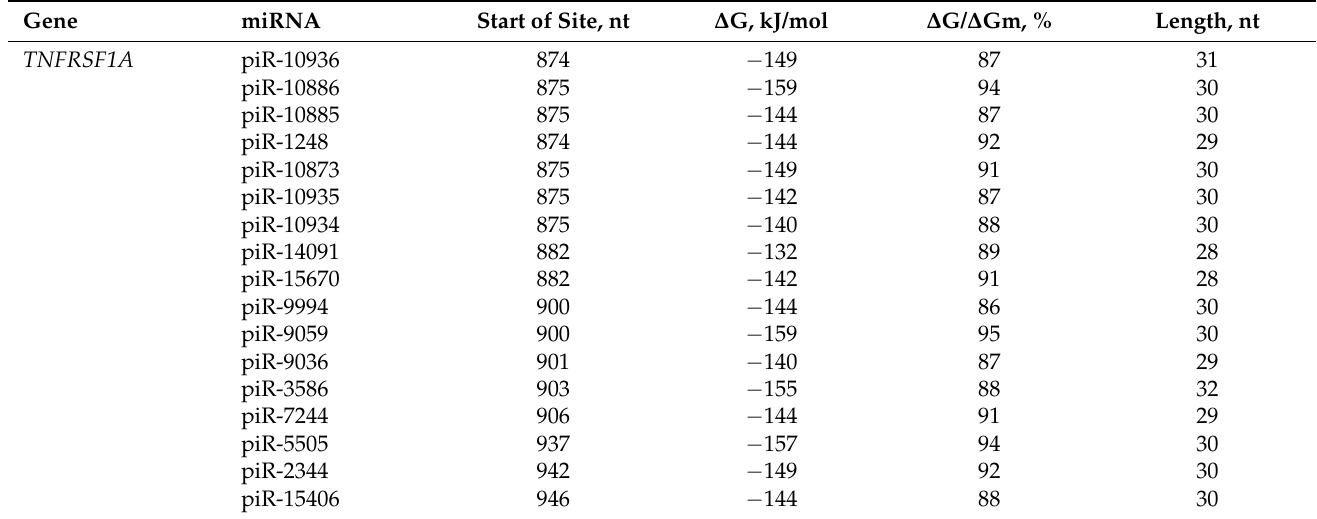
Table 4. Characteristics of interaction between piRNA and CDS mRNA of MS genes.